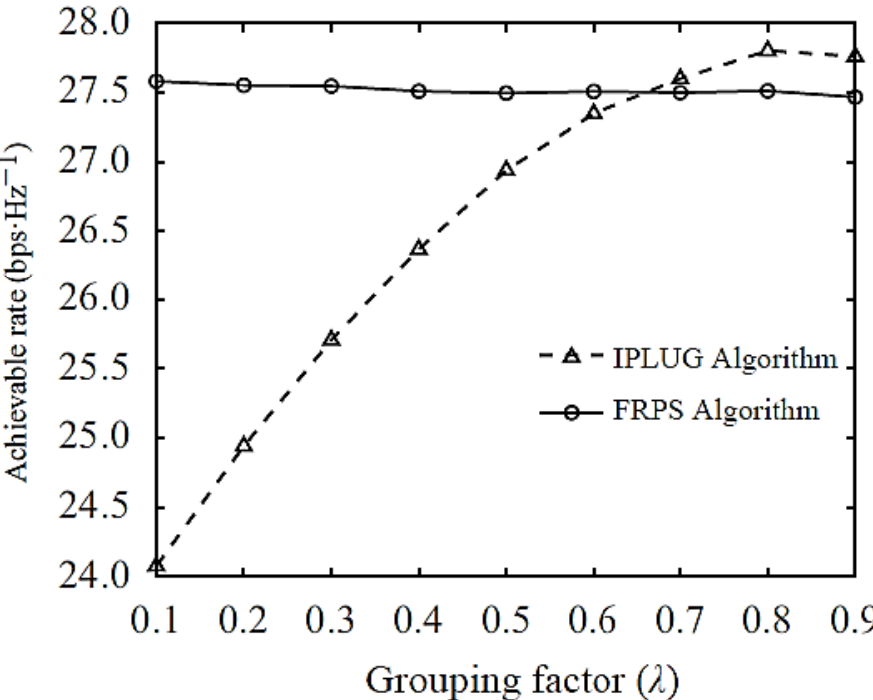
Figure 14. Comparison of achievable sum rate against a different number of user grouping factor λ for IPLUG and FRPS algorithms. Electronics 2019 , 8 , x FOR PEER REVIEW 21 of 27